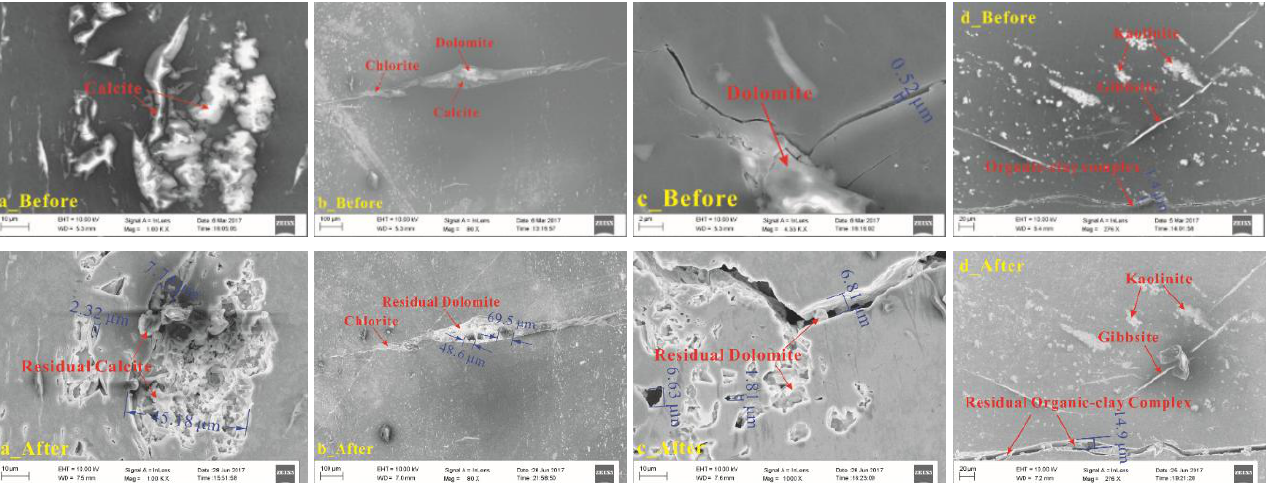
Figure 11—Pores, microfractures, and minerals in coal samples before and after CO 2